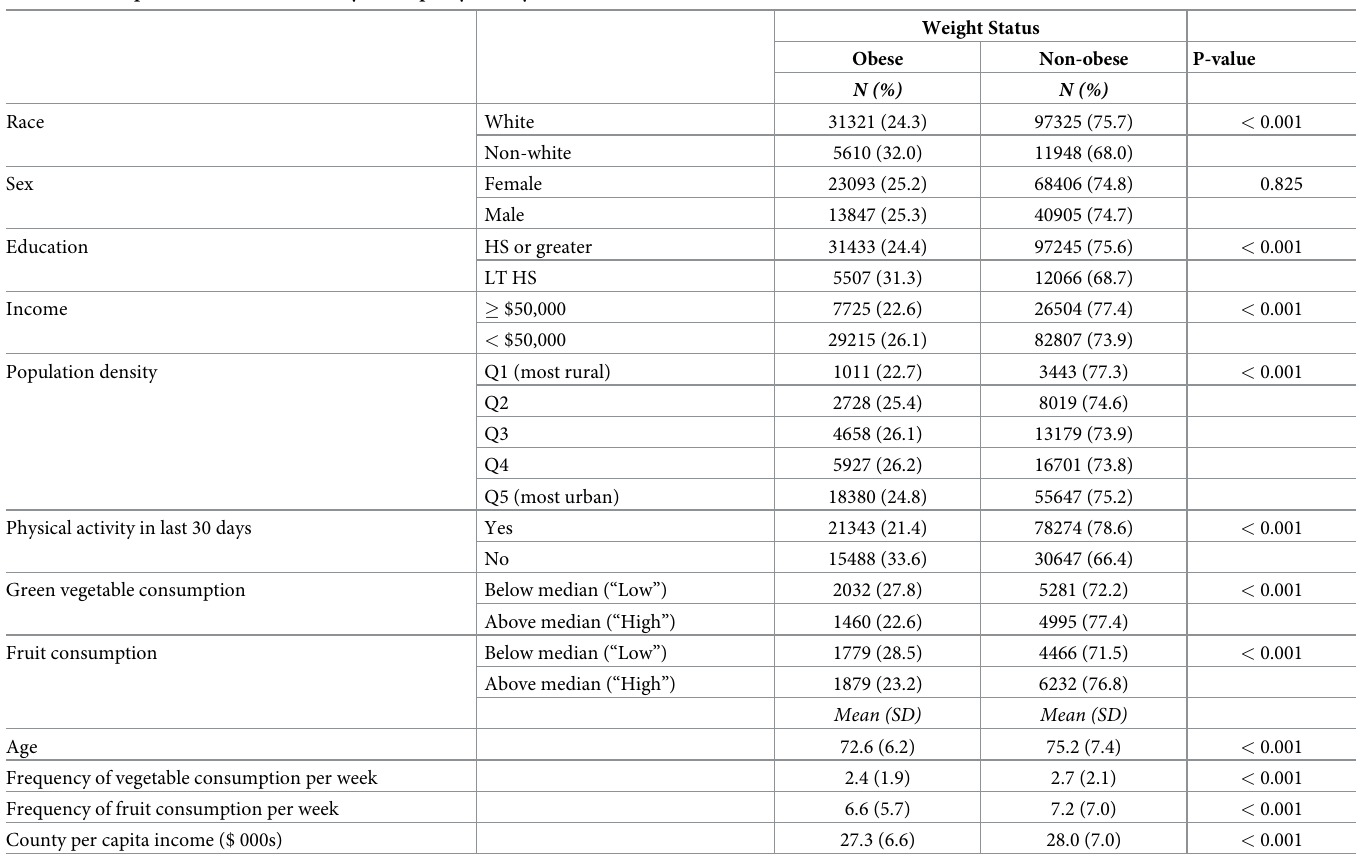
Table 1. Descriptive statistics for the analytic sample by obesity